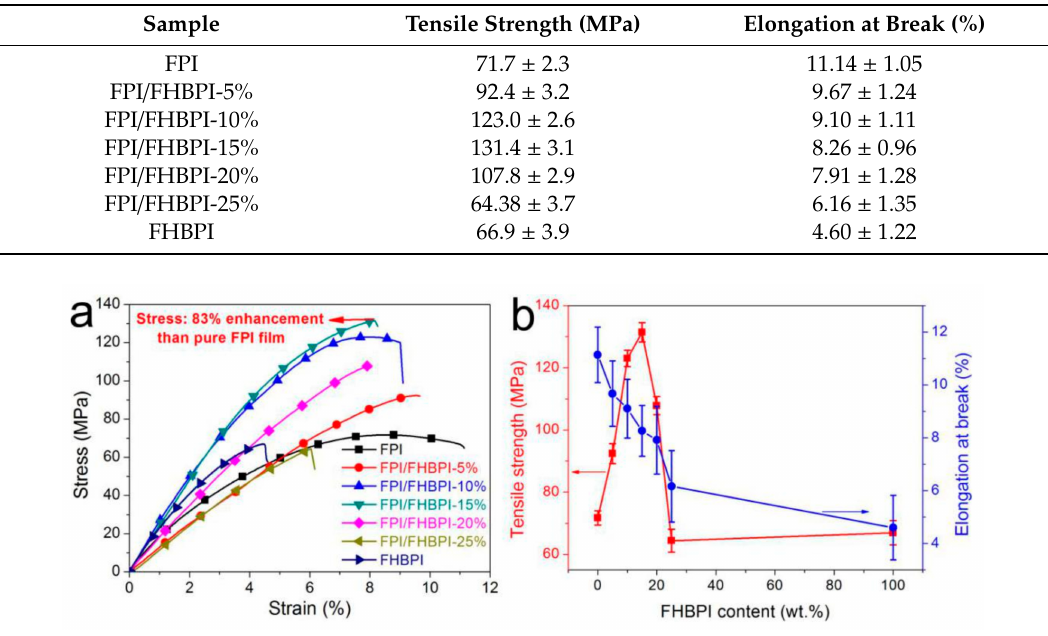
Figure 3. ( a ) Tensile testing curves of FPI, FPI / FHBPI composites and FHBPI; ( b ) E ff ects of FHBPI content on tensile strength and elongation at break of FPI composite